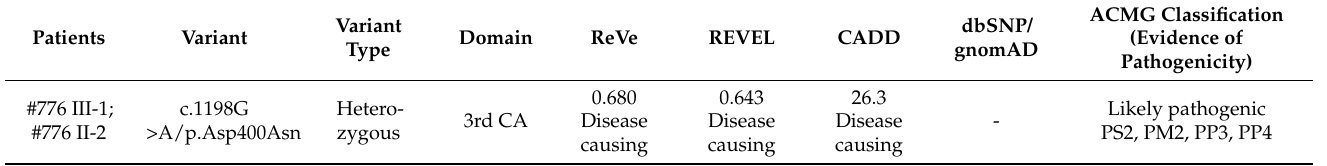
Figure 2. Family pedigree and sequencing chromatograms of the proband and family members in this study. ( A ) Pedigree of the BCD family #776. ( B ) Sequencing chromatograms showing a heterozygous CDH1 variant c.1198G>A (p.Asp400Asn) in the proband (III-1). ( C ) Sequencing chromatograms showing a heterozygous CDH1 variant c.1198G>A (p.Asp400Asn) in the proband’s mother (II-2). ( D – F ) Sequencing chromatograms showing a wild-type CDH1 genotype in the three healthy individuals (I-1, I-2, and II-1). Table 2. Pathogenic prediction of the CDH1 variant identified in this study.